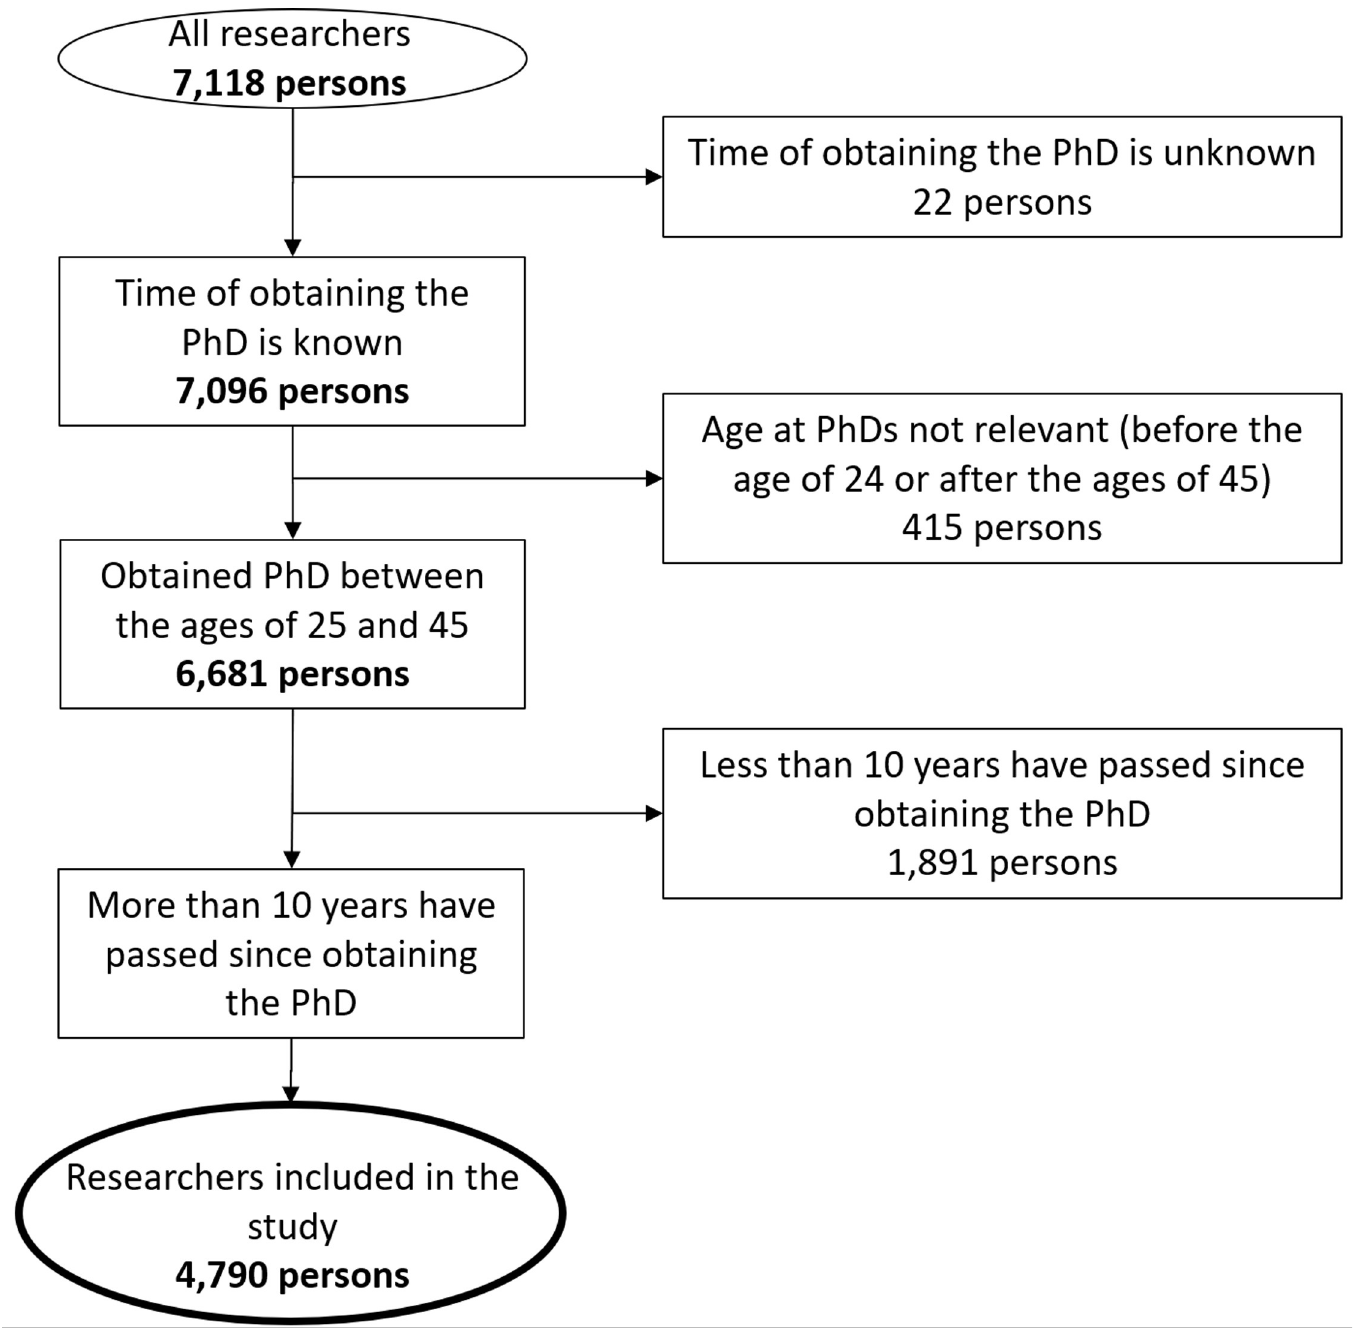
Fig 2. Flowchart of setting up the database up to the final cohort including 4,790 eligible researchers.